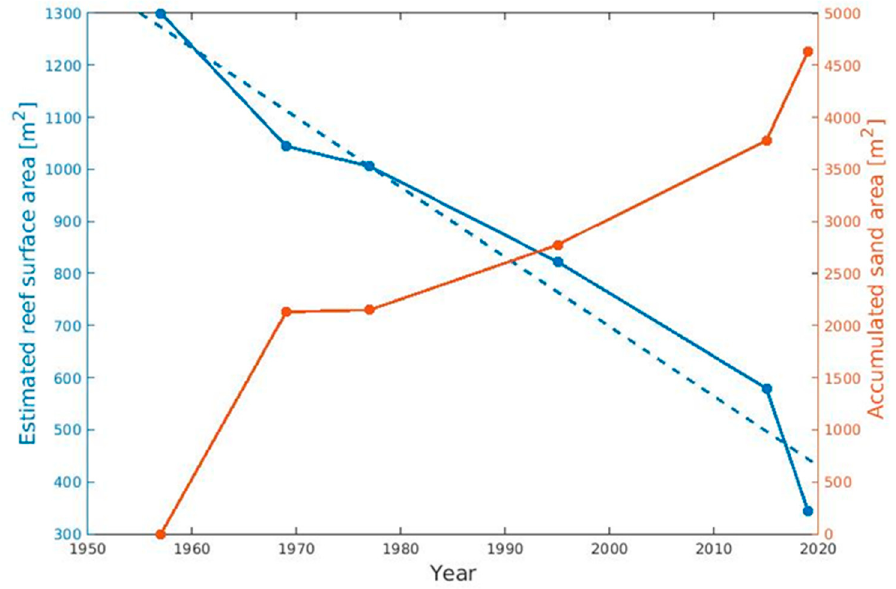
Figure 6. Changes in the estimated reef surface area (ERSA, solid blue line) and accumulated sand area (orange line), in the vicinity of Pier One between the years 1957 and 2015. Dashed line shows the linear trend in ERSA (R 2 = 0.96).